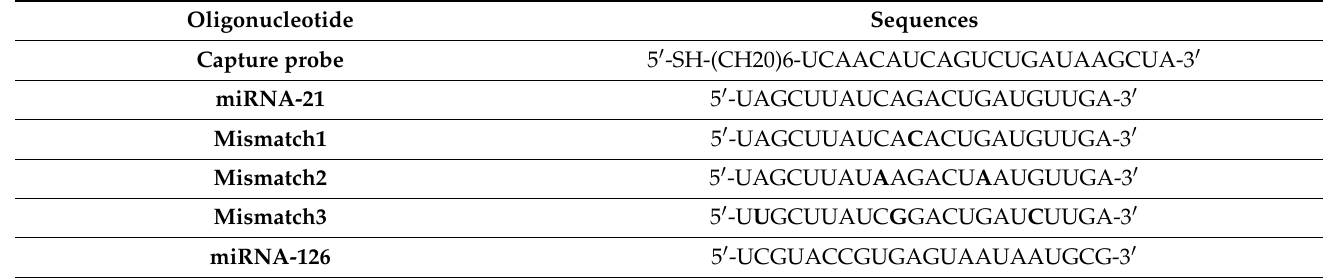
Table 1. Oligonucleotide sequences of ss-capture RNA (capture probe), miRNA-21(target), mismatch (1, 2, 3), negative control (miRNA-126). Oligonucleotide